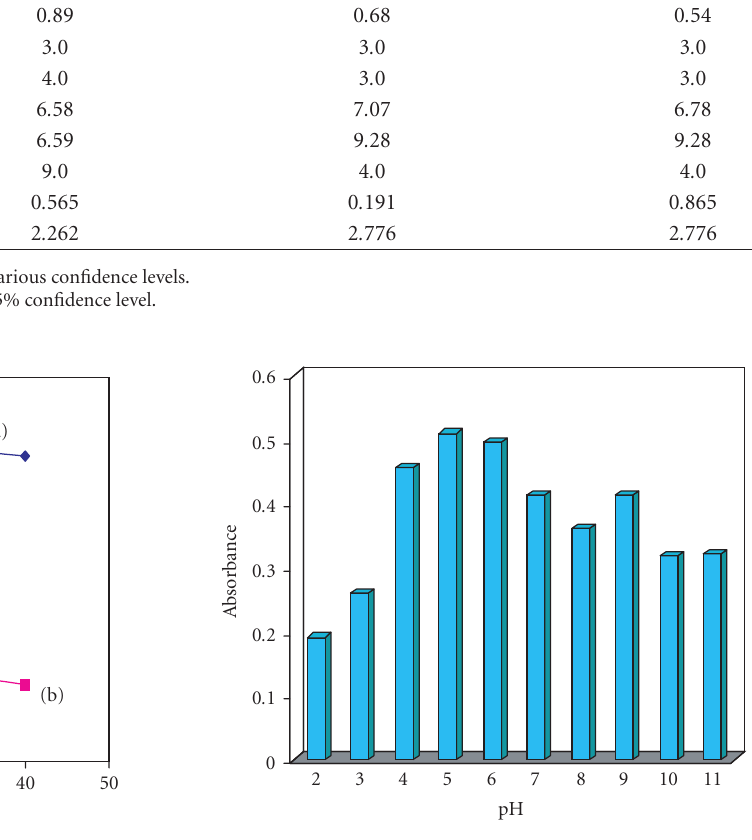
Figure 4. E ff ect of time on the absorbance of (a) LD and (b) CD with copper tetramine and 4-AAP.